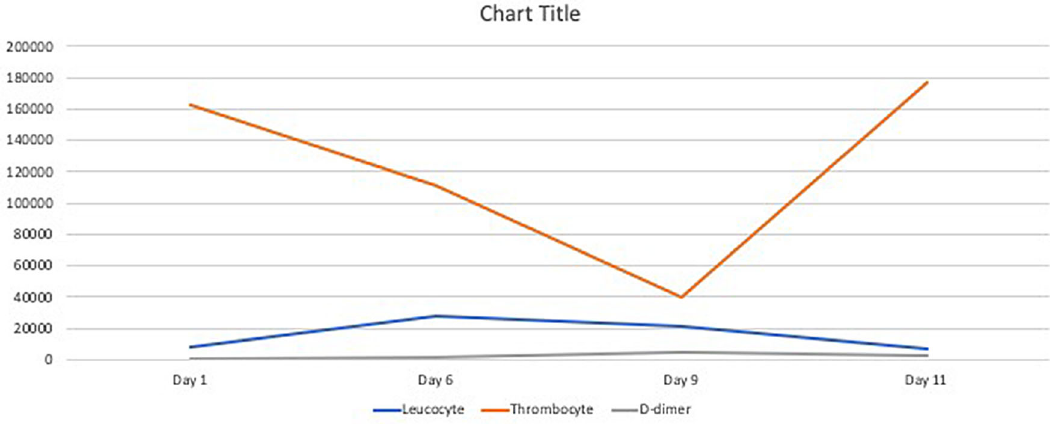
Figure 3. Summary of laboratory